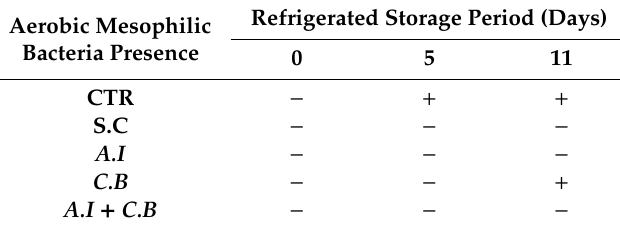
Table 4. E ff ect of A. indica and C. baccatum on microbial quality of raw beef meat during refrigerated (4 ± 1 ◦ C) storage.